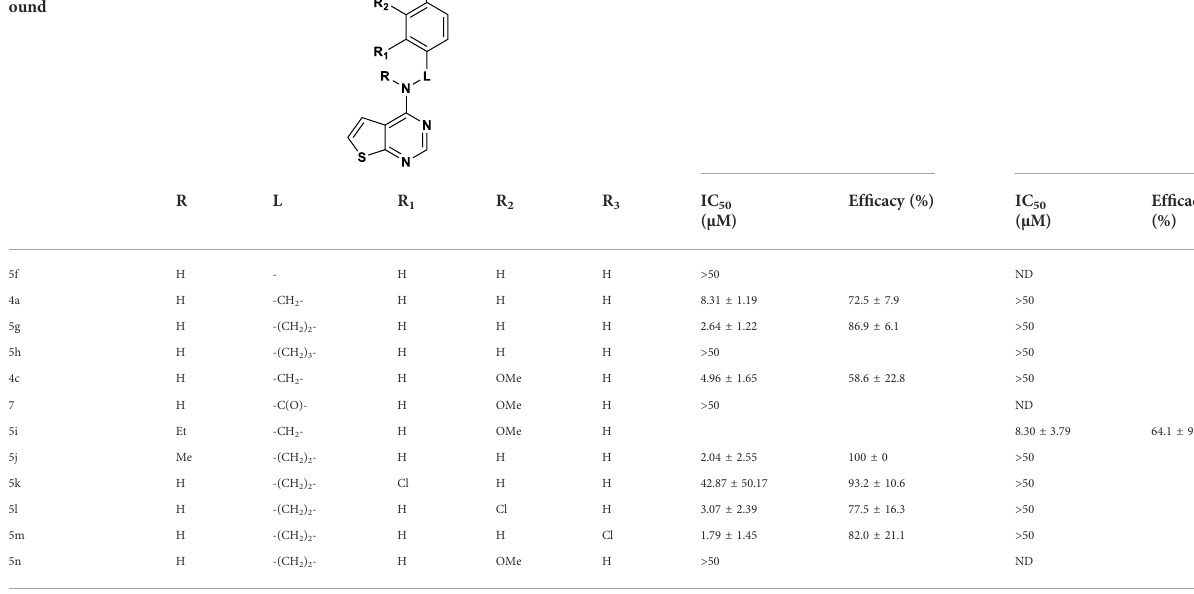
TABLE 3 SAR exploration of the linker part of thieno[2,3-d]pyrimidine. Comp- ound